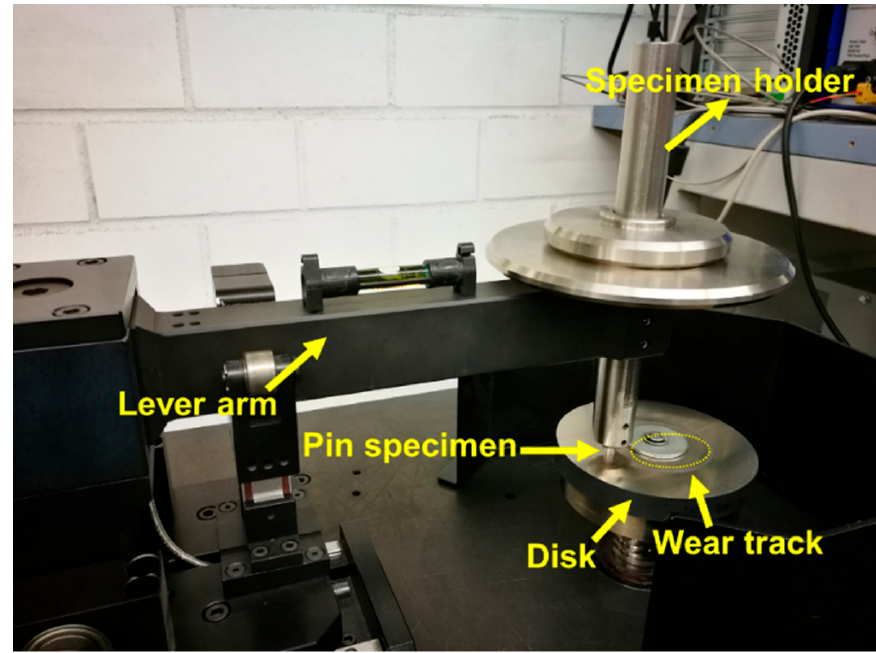
Figure 2. Photograph of the pin-on-disk wear test setup.